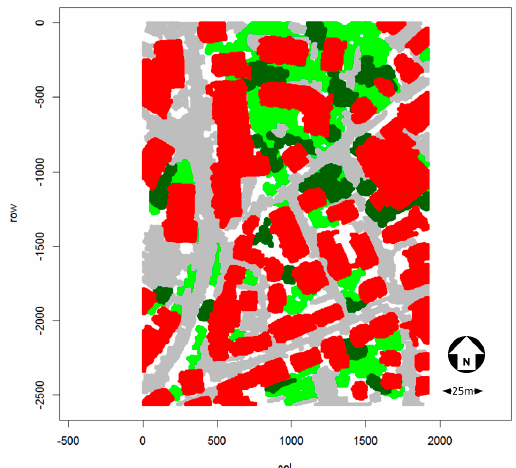
Figure 10. Enhanced land cover map (Level 1). (red = “building”, dark green = “tree”, green = “low vegetation”, grey = “impervious surface”, white = “no data”; units of the image coordinates are pixels).